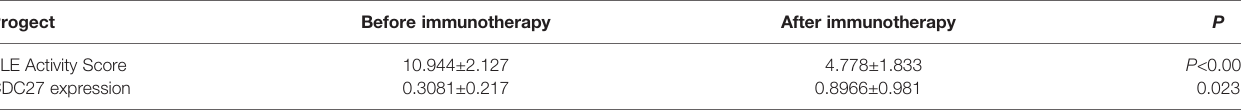
TABLE 2 | The relationship between the expression of CDC27 in PBMC of SLE patients and immunosuppressive therapy. Progect